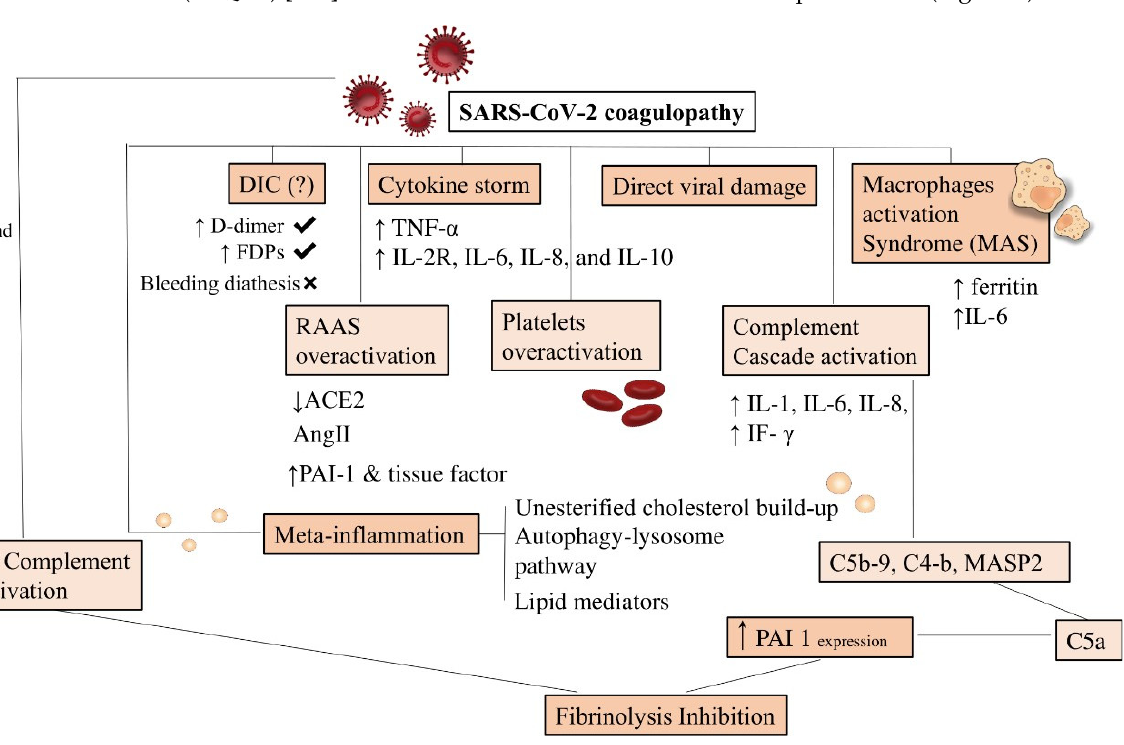
Figure 5. Summary of the dysregulations in coagulation system after SARS-CoV-2. SARS-CoV-2 coagulopathy is supported by the following pathological events: DIC, cytokine storm process, and direct action of the virus, inducing damage and activation of macrophages. RAAS overactivation associated with platelet and complement overactivation (direct and indirect) leads to fibrinolysis inhibition. Abbreviations are as shown in previous figures. Arrows explain the increase or decrease of relative